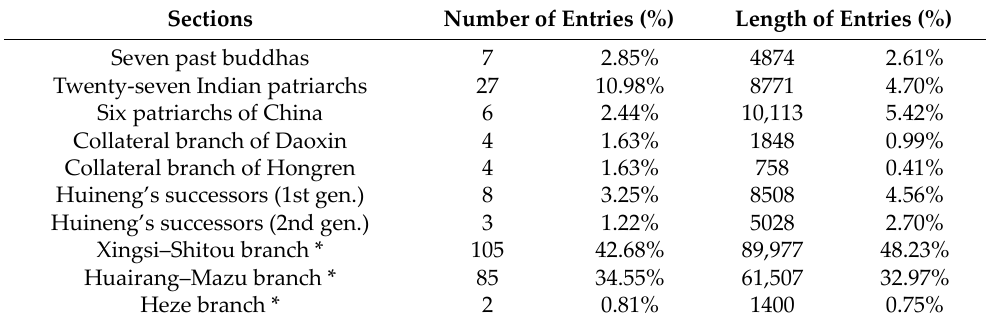
Table 4. Proportion of sections of the ZTJ according to the length of the entries (in characters). Sections Number of Entries (%) Length of Entries (%) Seven past buddhas 7 2.85% 4874